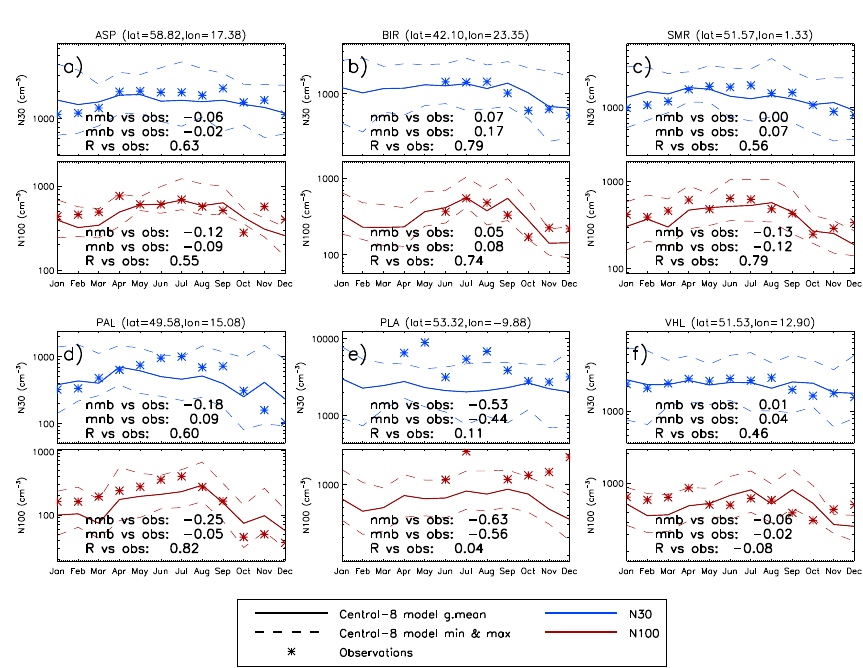
Figure 11. Annual cycle of simulated N(D p > 30nm) (blue), and N(D p > 100nm) (red) against those measured by SMPS/DMPS instru- ments (asterisks) at the six Nordic and Baltic EUSAAR sites: Aspvreten (ASP, a ), Birkenes (BIR, b ), Hyytiala (SMR, c ), Pallas (PAL, d ), Preila (PLA, e ) and Vavihill (VHL, f ). Model values are the geometric mean (solid) and min/max (dashed) over the central-8 model monthly mean values. Observed values are arithmetic means over the hourly measurement data (A. Asmi, personal communication, 2012).